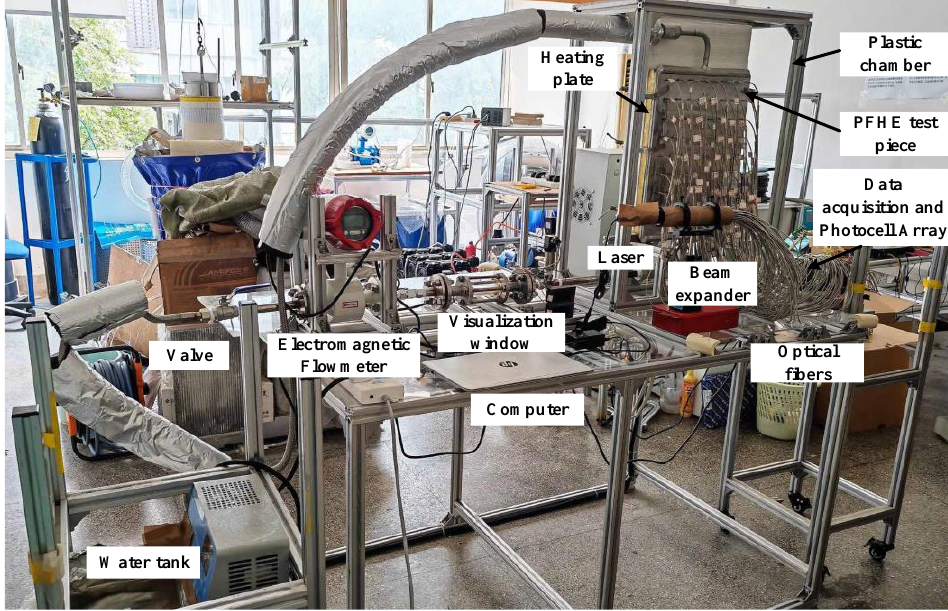
Figure 8. Laboratory implementation of the experimental setup of flow boiling in PFHE.